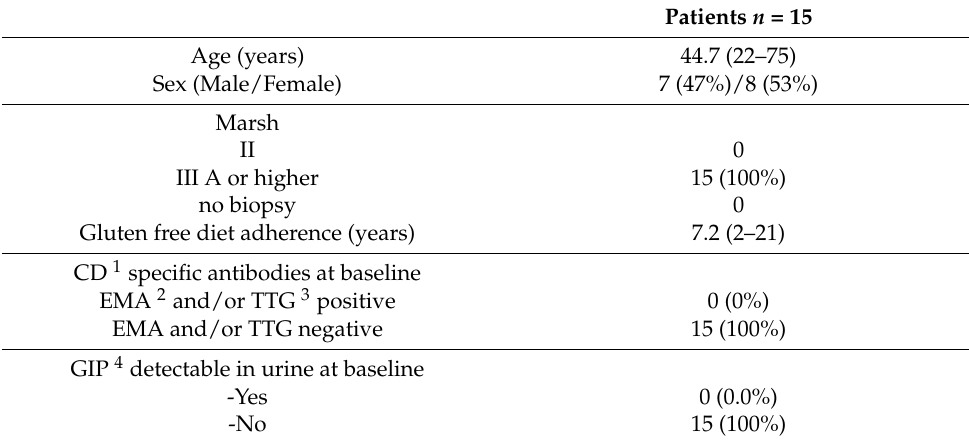
Table 1. Patient